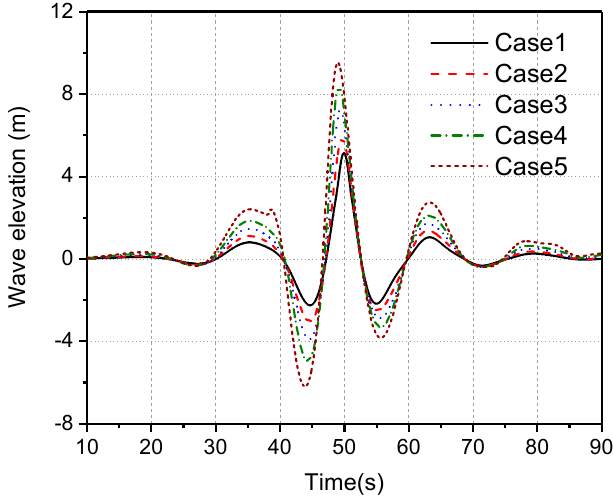
Table 5. Focused wave parameters with incident wave peak period T p = 15.0 s.